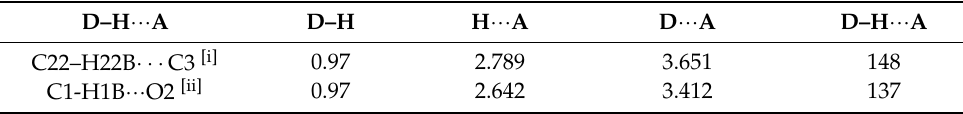
Table 2. Hydrogen-bonds geometry (Å, ◦ ) of 2